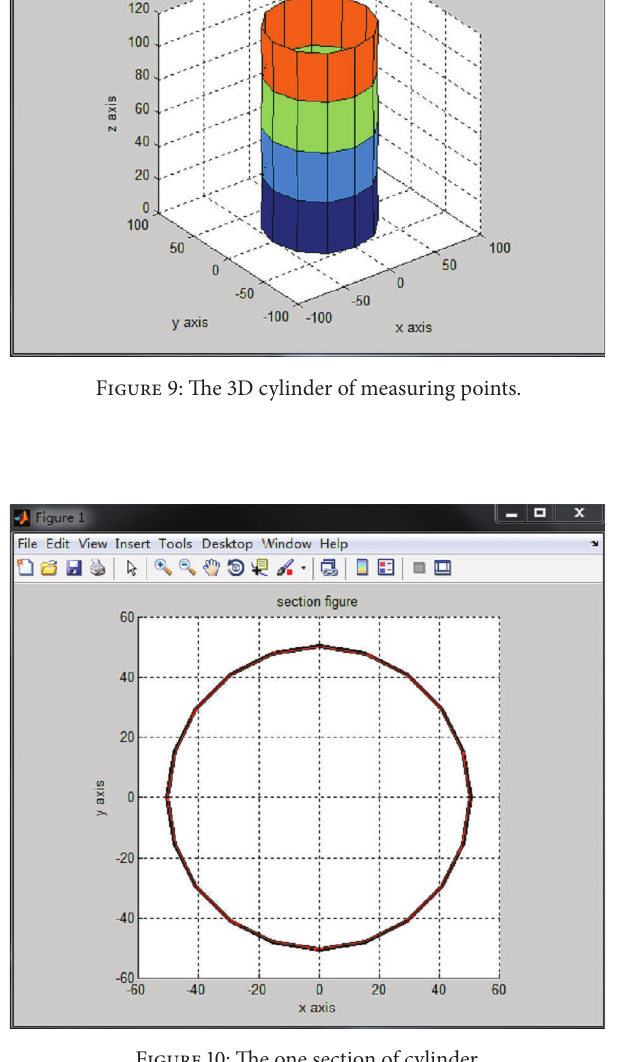
Figure 10: The one section of cylinder.